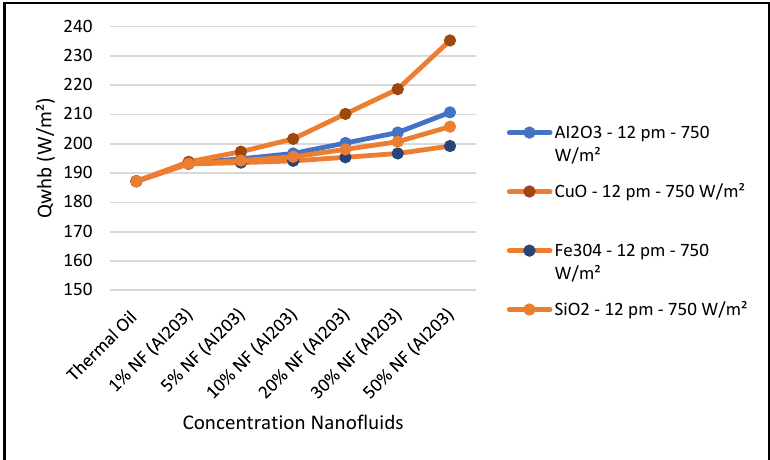
Figure 25. CSP system hybrid ORC waste heat boiler with different nanofluids at different concentrations.